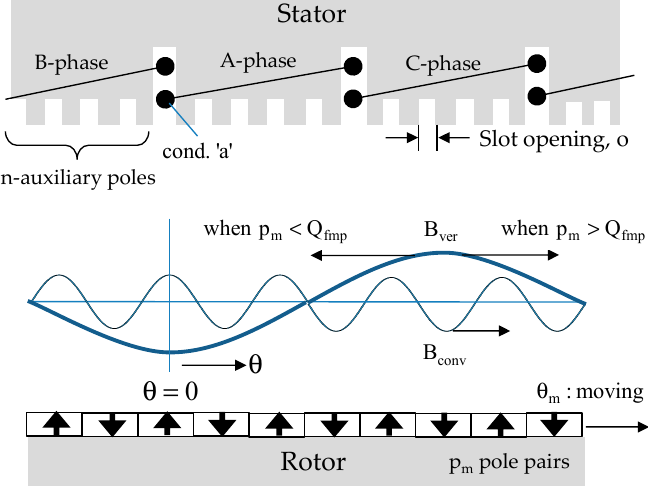
Figure 1. Conceptual structure of a FSCW-PM vernier motor.